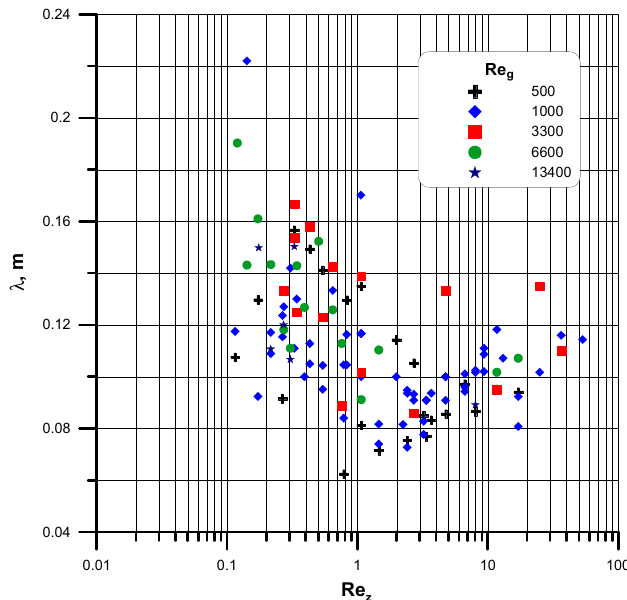
Figure 8. Results of experiments and calculations of dependencies between wavelength λ = f(Re z , Re g ) accompanying annular gas-very viscous liquid flow.